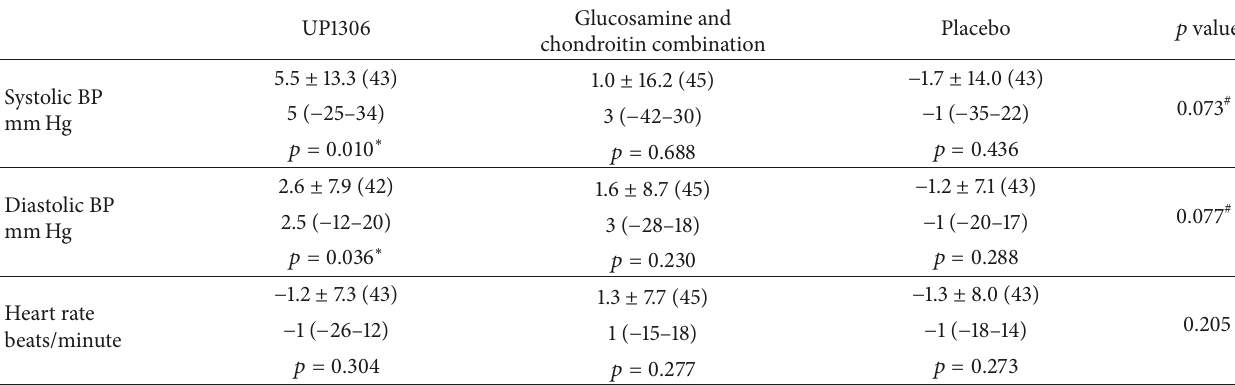
Table 4: Change from baseline in vital signs over 12